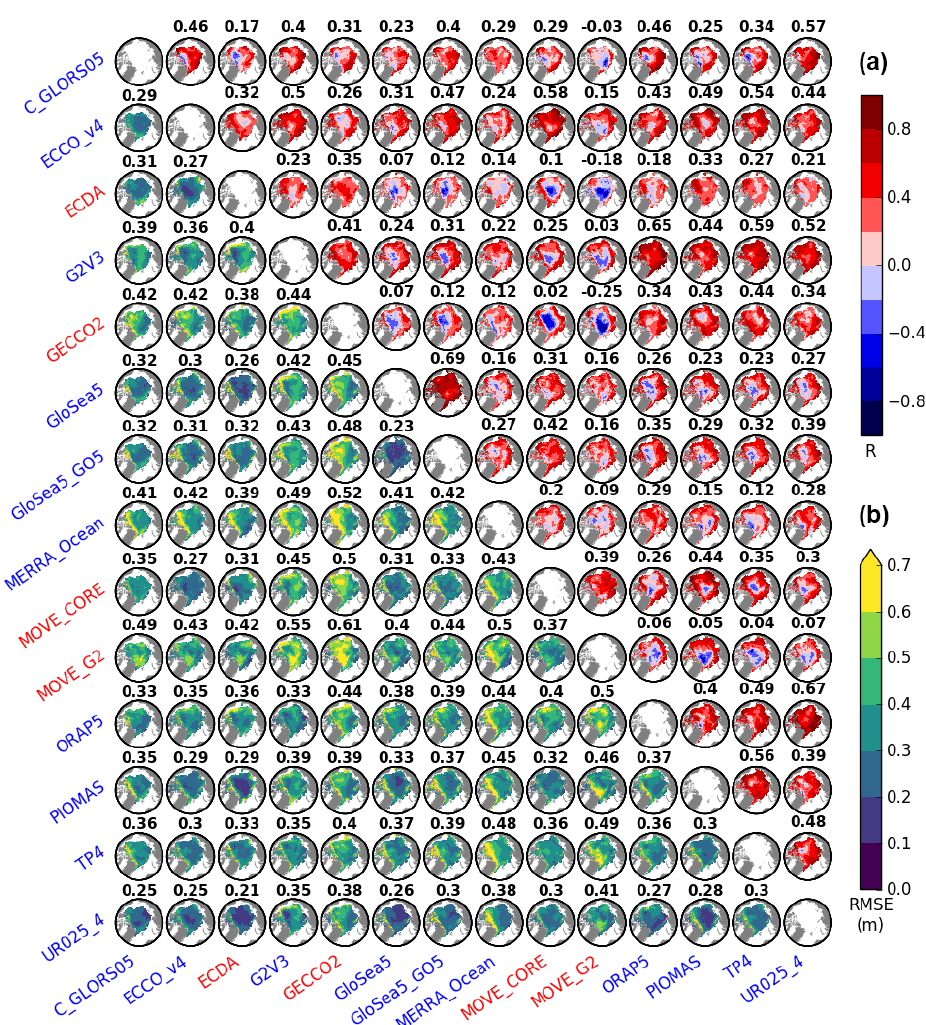
Figure 5. Square matrix plot displaying the root mean square error (RMSE) (a) and the correlation coefficient ( R ) maps (b) , estimated from the sea ice thickness time series, at every grid point, and between all pairs of reanalyses. The numbers at the top of each panel indicate the respective value calculated with data from all grid points. All maps have the 0 ◦ longitude placed at 06:00, while the bounding latitude is 67 ◦ N. Reanalyses labeled in blue and red highlight whether the datasets were built with or without ice data assimilation,